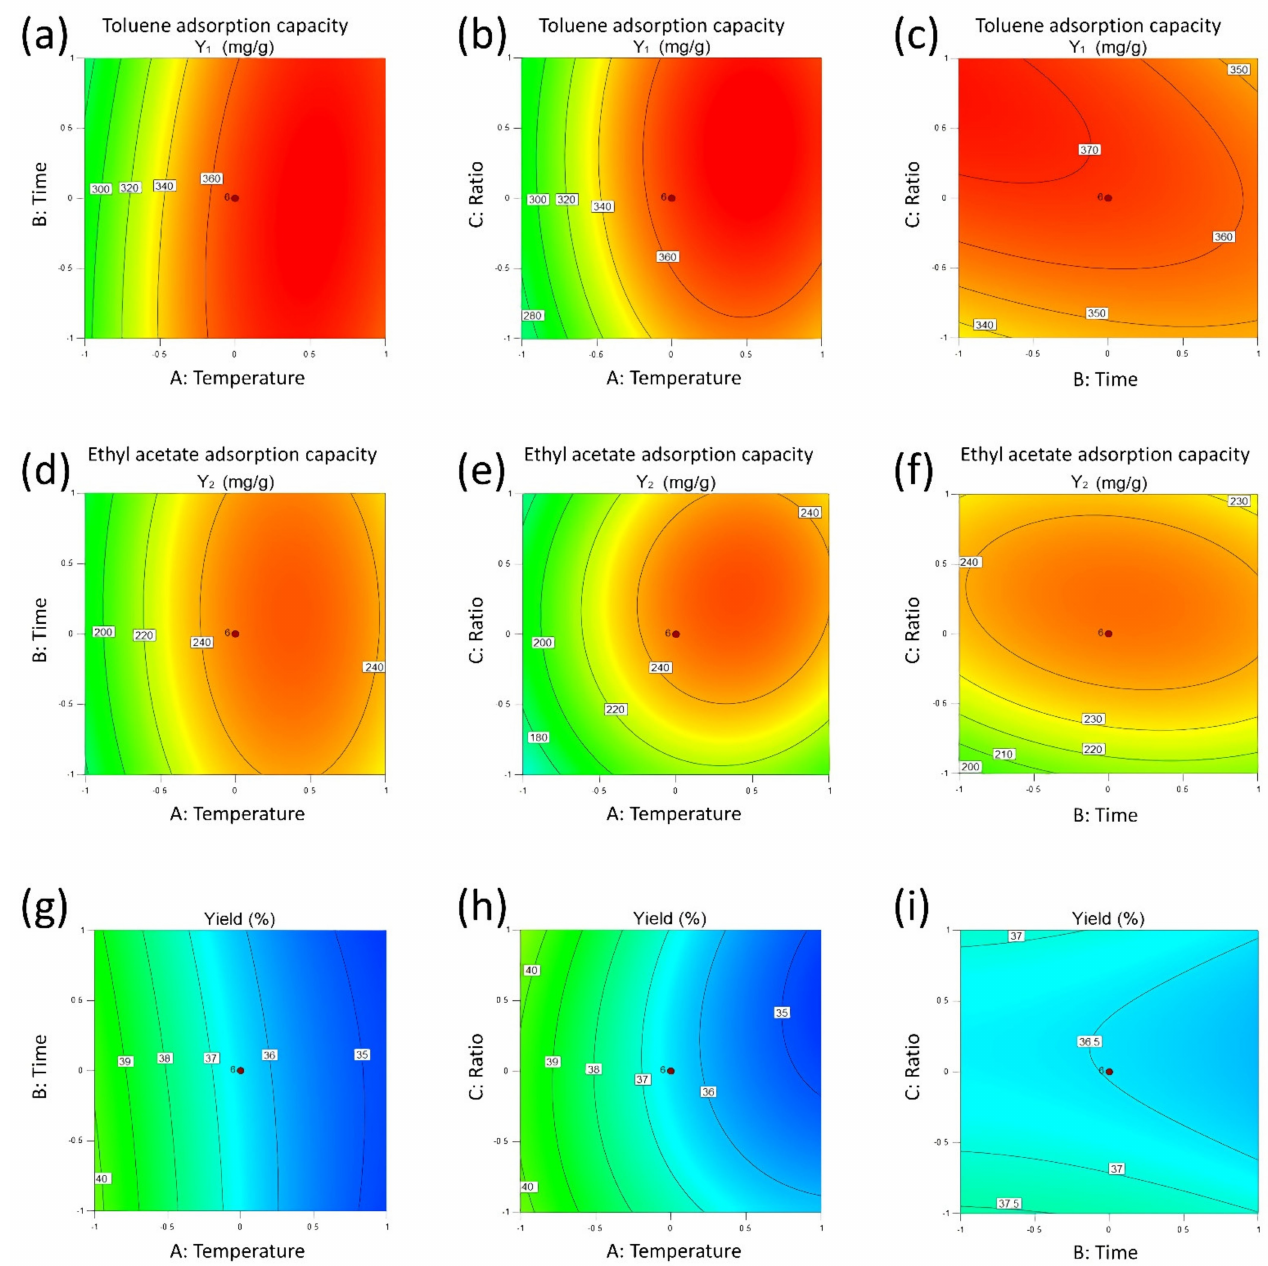
Figure 4. Contour maps of surface response plots for toluene adsorption capacity ( a – c ), ethyl acetate adsorption capacity ( d – f ) and carbon yield ( g – i